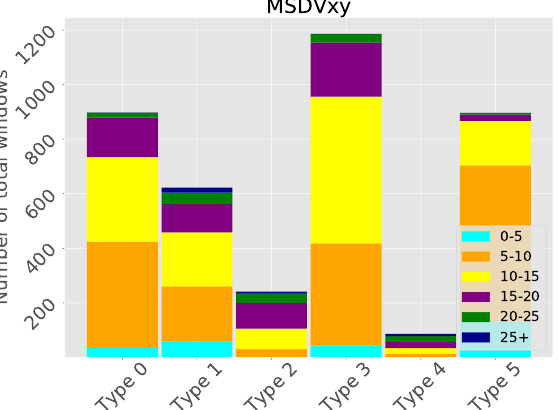
Figure 4. MSDVxy values for each road type. Criteria values are classified in five intervals that can be distinguished by color. The total number of windows depends on the length of each